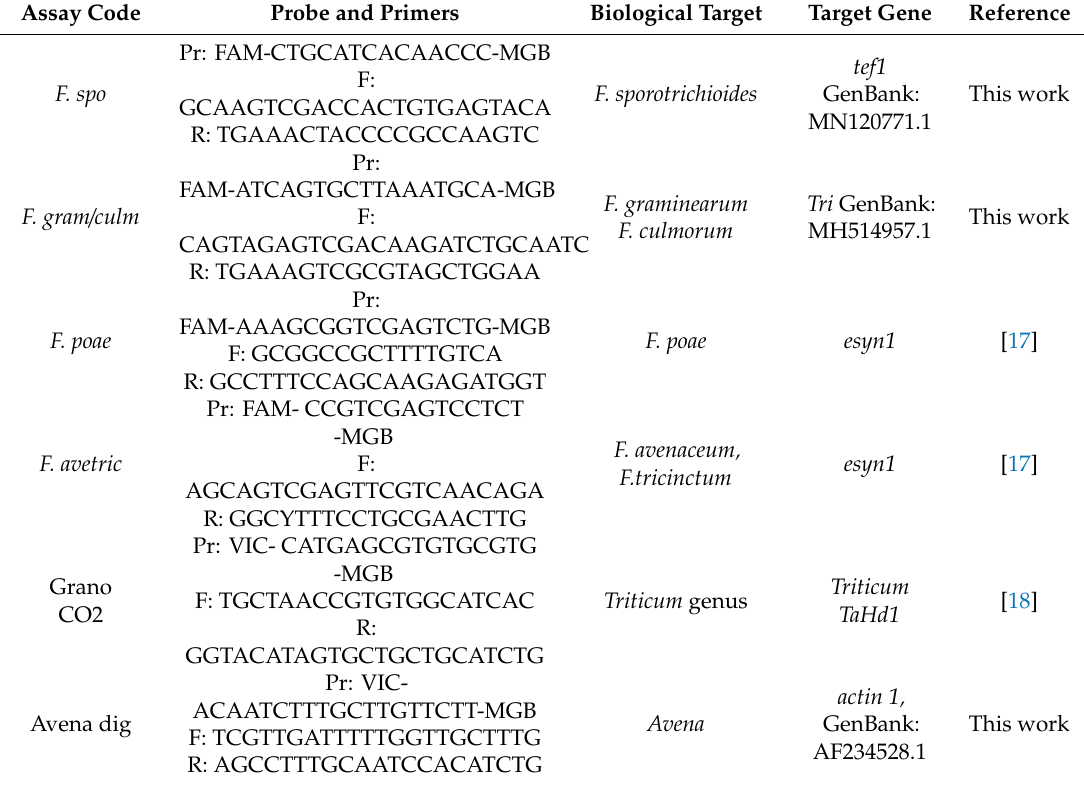
Table 1. Primer and probe sequences used in the study to target di ff erent Fusarium and plant